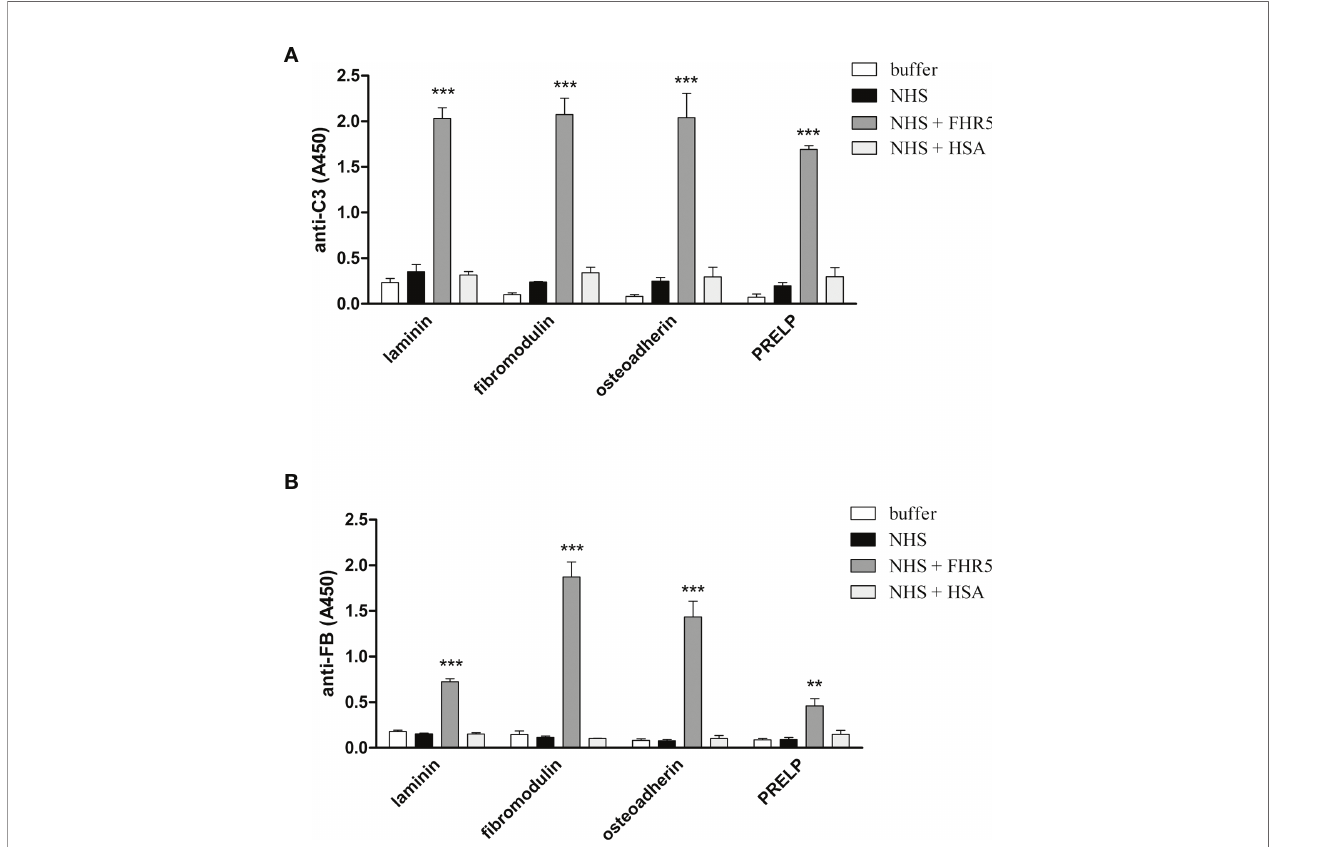
FIGURE 8 | FHR5 causes enhanced C3 fragment deposition and supports alternative pathway activation when bound to ECM proteins. Immobilized ECM proteins were incubated with 10% NHS in the presence or absence of 10 µg/ml FHR5, supplemented with 5 mM Mg 2+ -EGTA which allows only alternative pathway activation. Binding of C3 fragments and factor B was detected with HRP-conjugated anti-human C3 Ab (A) and goat anti-human FB Ab (B) . Data are means ± SD derived from three experiments. **p < 0.01, ***p < 0.001, one-way